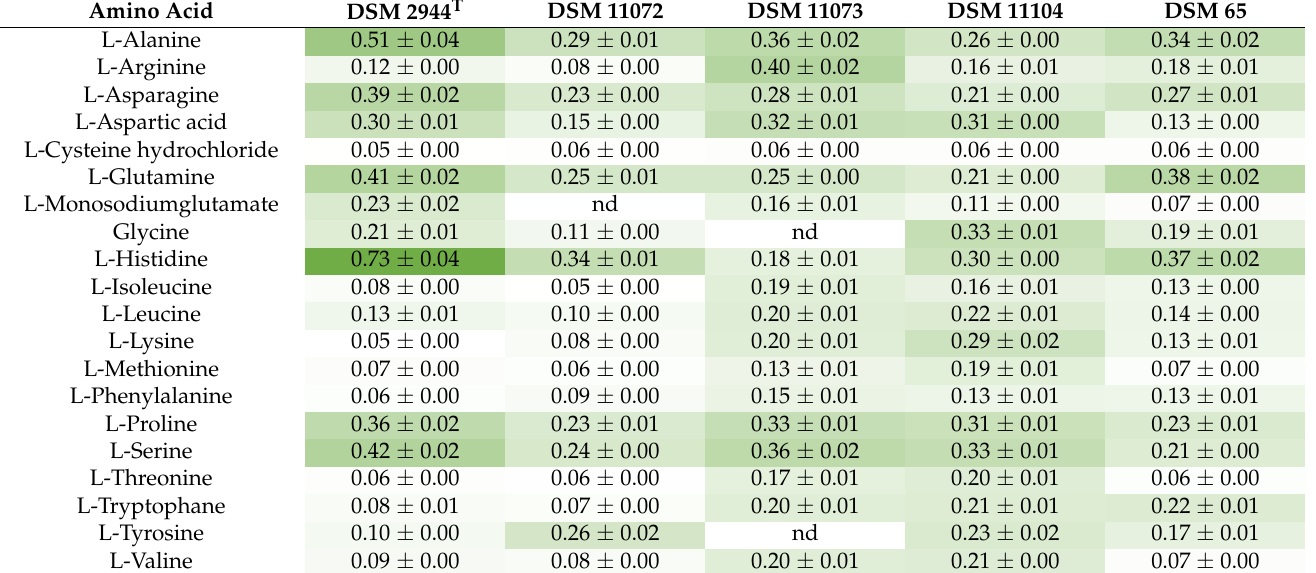
Table 3. Growth rates (h − 1 ) reached with amino acids as nitrogen sources. The experiments were performed in triplicates in 96-well plates at 30 ◦ C with 20 mM glucose over the course of 24 h. Online green value data were recorded, and values were transformed into OD values to automatically calculate growth rates via an in-house MATLAB script. nd = no exponential growth